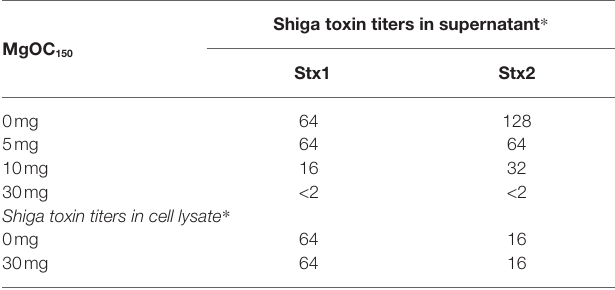
TABLE 2 | Shiga toxin titers in EHEC culture supernatant and cell lysate.